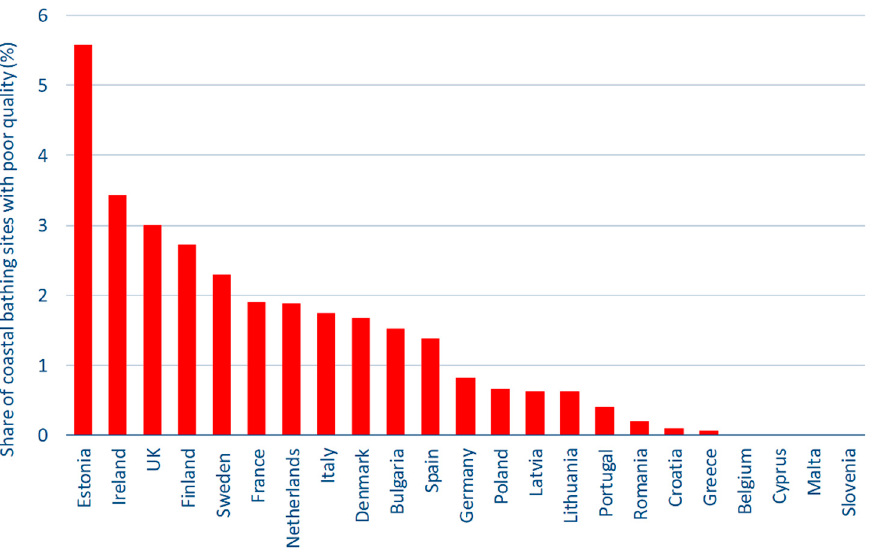
Figure 10. The average share of coastal bathing sites of poor quality in the EU countries during the period 2011–2020.